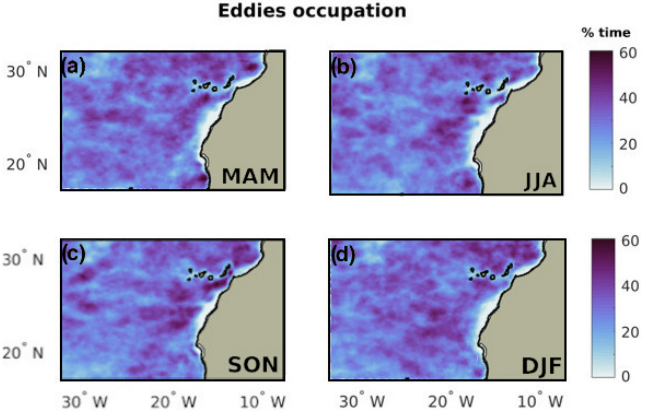
Figure B7. Eddies occupation by season.